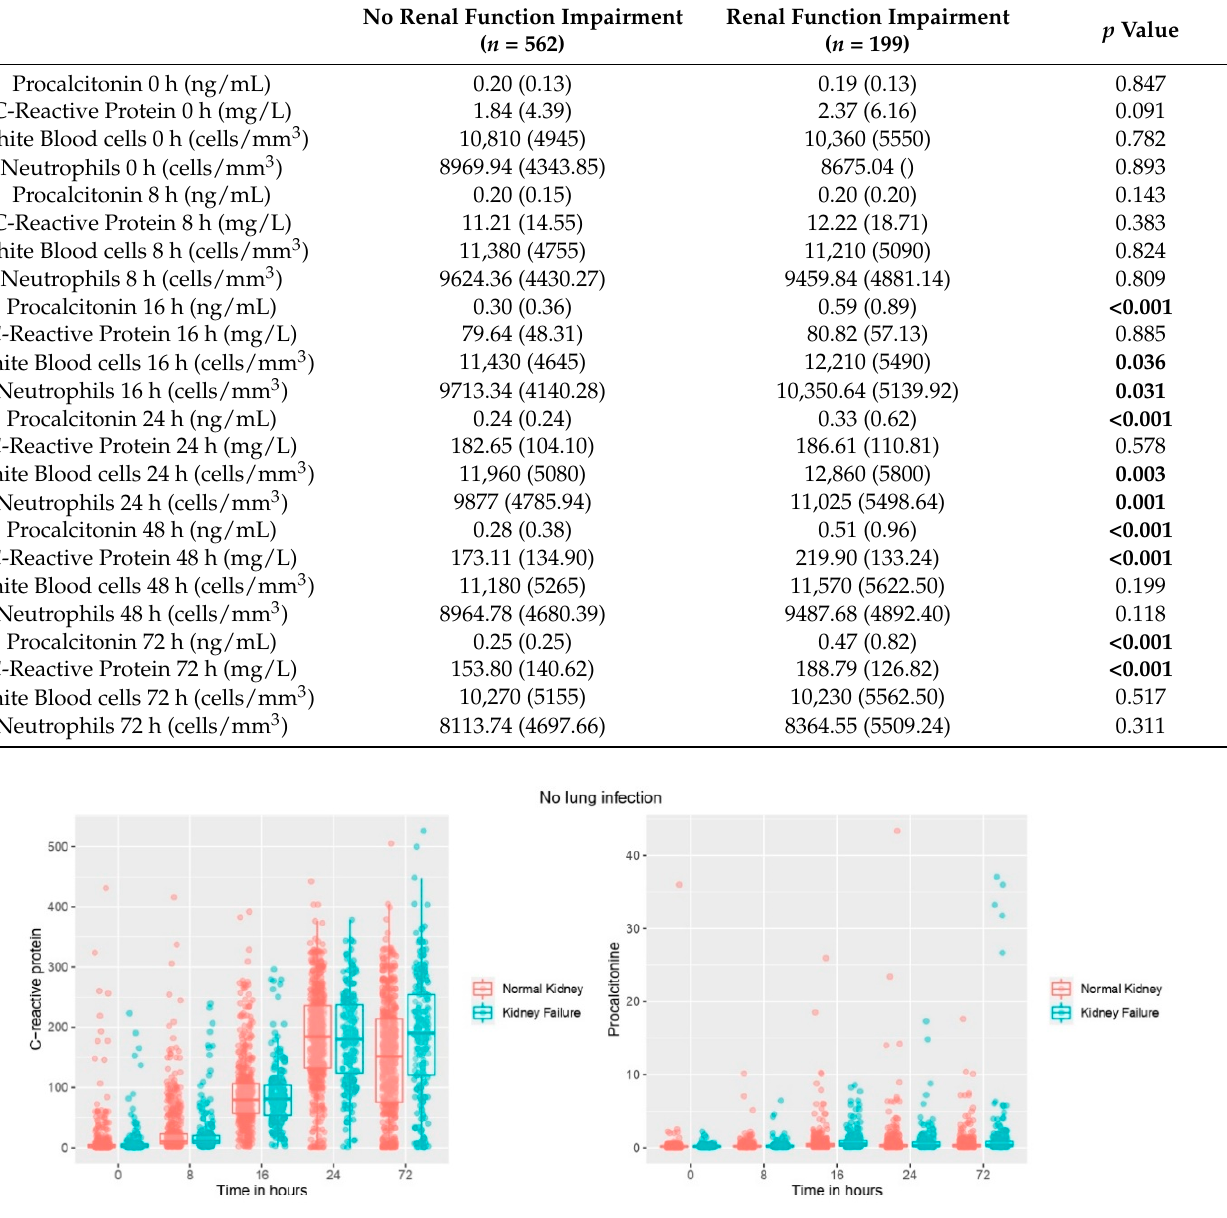
Figure 2. Box plots showing biomarker levels over time based on the presence/absence of renal failure in patients without infection. 3.4. Biomarkers Association with Presence of Renal Failure over Time in Patients with Infection The generalised linear mixed model (GLMM) revealed a significant effect on creatinine clearance of all variables except neutrophils. Under this model, taking time into account and considering each individual as a random factor, we observed that PCT decreases by 0.33 ng/mL for each unit that increases creatinine clearance (Table 4). Table 4. Generalised linear mixed models (GLMM) for evaluating the association between biomarkers and creatinine clearance over time in patients with lung infection. Estimate